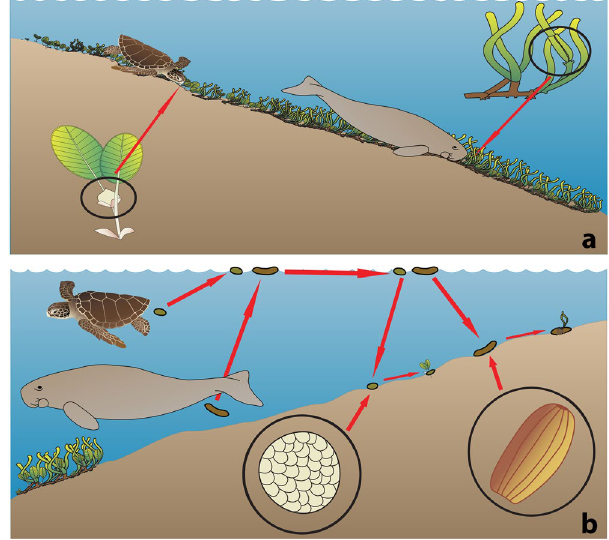
Figure 1. Illustration of biotic dispersal of seagrass seeds by marine mega- herbivores. ( a ) Ingestion of seagrass seeds or propagules by a dugong or green sea turtle allows long distance dispersal of the seed; ( b ) before settlement and growth into a seedling. Figure created by Samantha Tol, using images provided by Tracy Saxby, Catherine Collier, Diana Kleine, and the Integration and Application Network, University of Maryland Center for Environmental Science